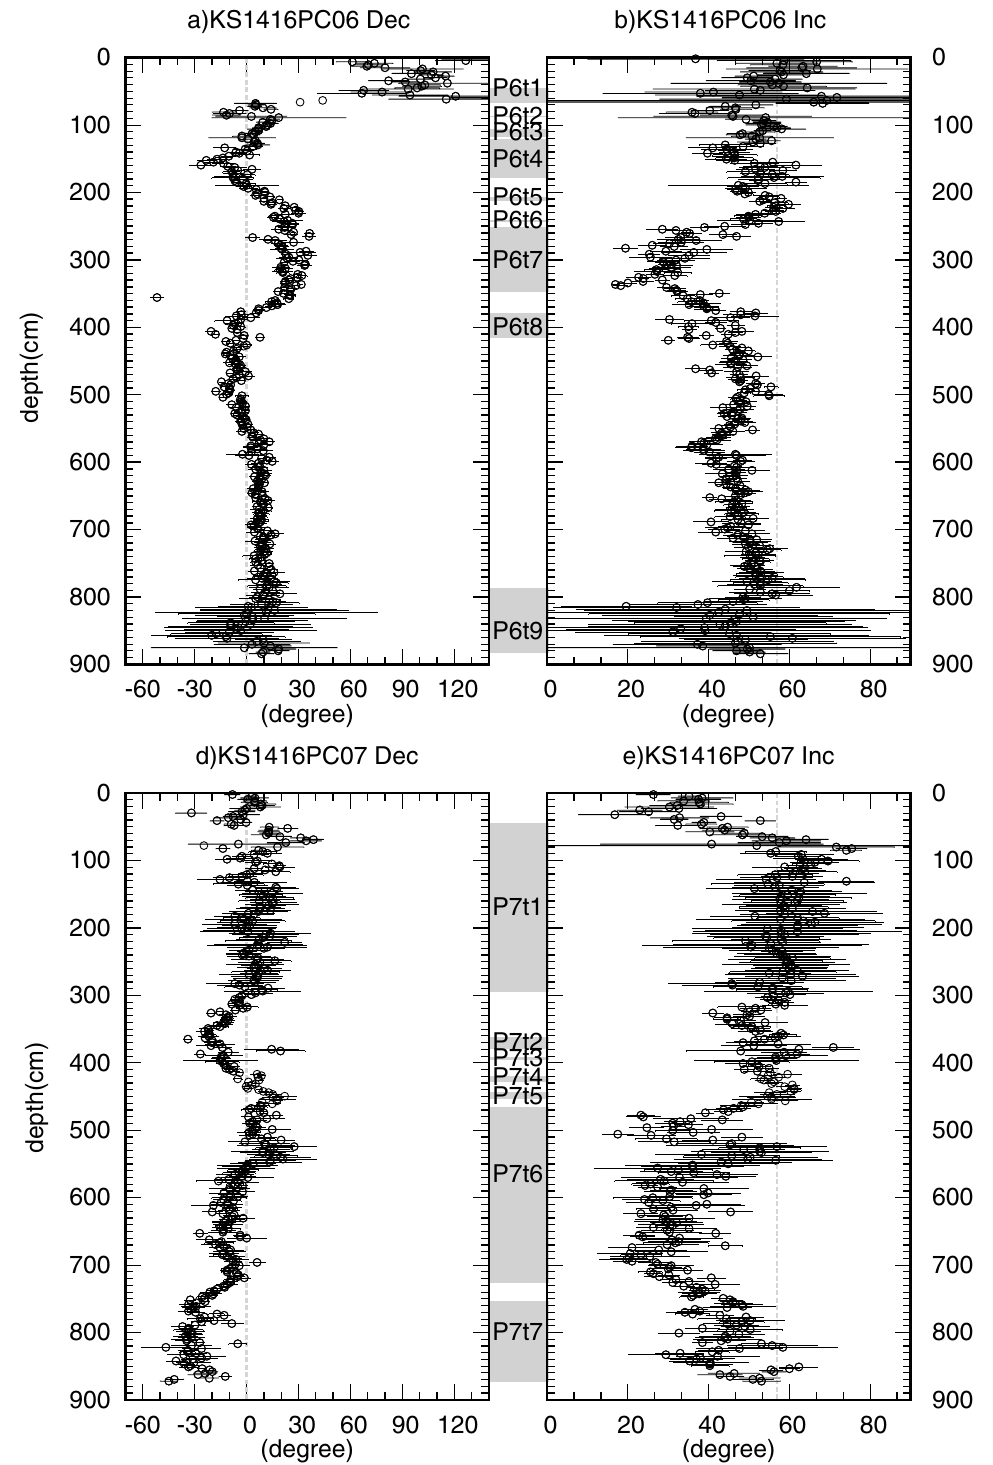
Fig. 5 a , e declination data with 0° (gray broken line) for cores KS1416PC06 and KS1416PC07, and b , d inclination data with GAD inclination (gray broken line) for cores KS1416PC06 and KS1416PC07, respectively. ΔD 95 and ΔI 95 (Khokhlov and Hulot 2016) shown with declinations and inclinations. Gray hatched intervals indicate turbidite